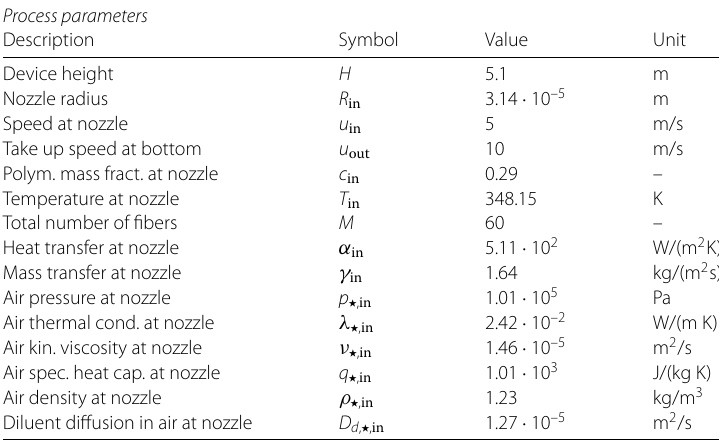
Table 3 Process parameters of the industrial dry spinning setup (cf. Fig. 1) assuming the airflow without fibers (first step in the fiber-airflow coupling) Processparameters